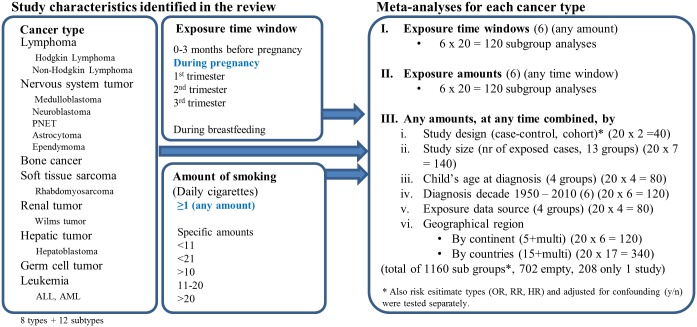
Cancer (sub)types which were analyzed according to exposure time window and exposure amount.Sensitivity analyses were conducted for nine study characteristics using studies reporting “any” smoking “during pregnancy”. Exposure amount is given in cigarettes per day (CPD). PNET = primitive neuroectodermal tumor; ALL = acute lymphoblastic leukemia; AML = acute myeloblastic leukemia.